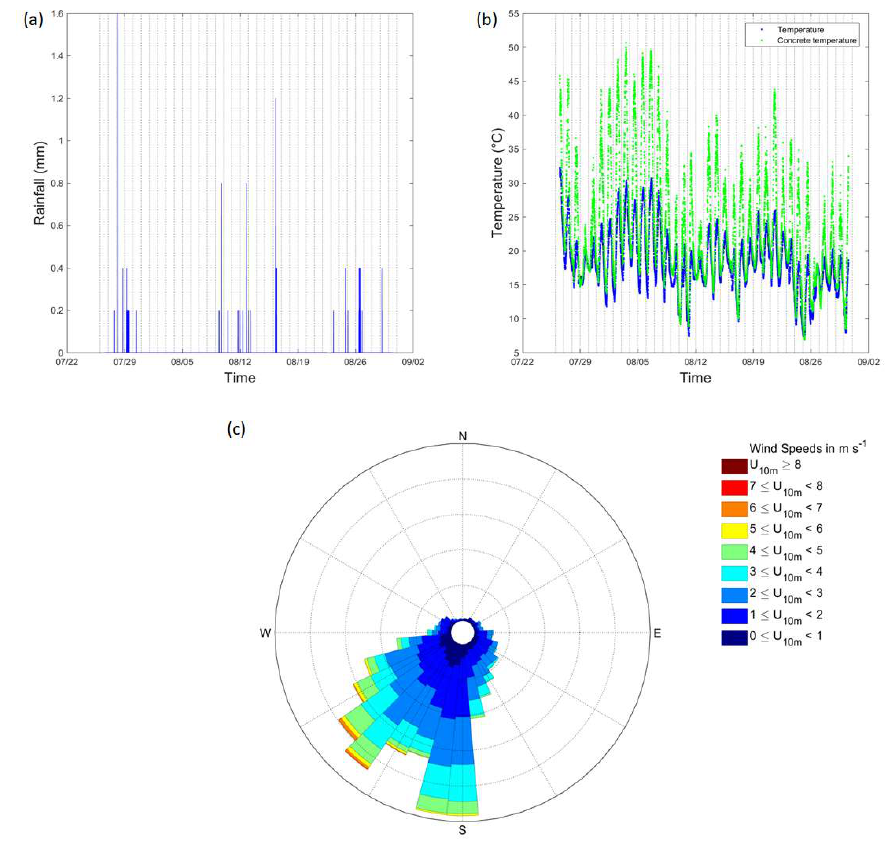
Figure 5. Observations from UoRAO for the study period. ( a ) rainfall, ( b ) temperature and concrete temperature, and ( c ) wind direction and 5-min wind speed at 10 m (meteorological standard). Vertical grey lines denote midnight of each day.